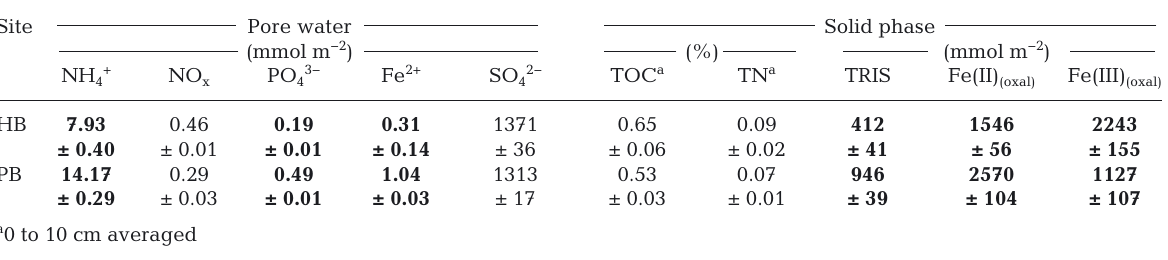
near the surface to 31.7 µmol cm −3 at 5−6 cm depth (Fig. 3d,e). Fe(III) comprised >80% of total Fe (oxal) (i.e. Fe(II) + Fe(III)) at 0−4 and 0−2 cm depth at the